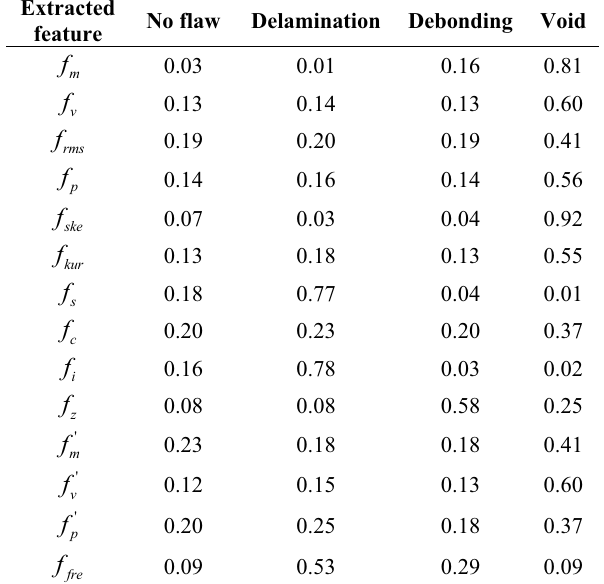
Table 3. Features of IMF3 for different flaw